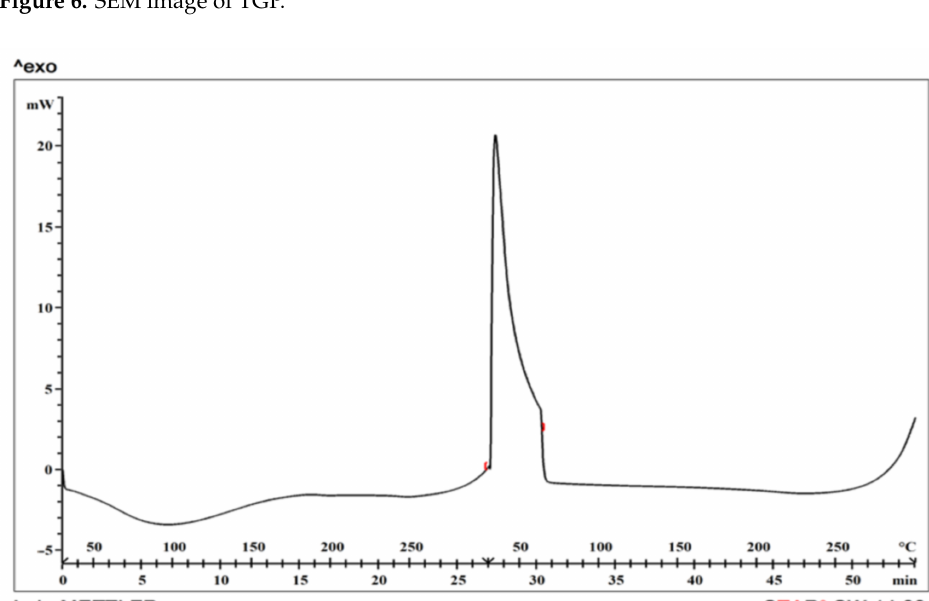
Figure 7. DSC thermogram of